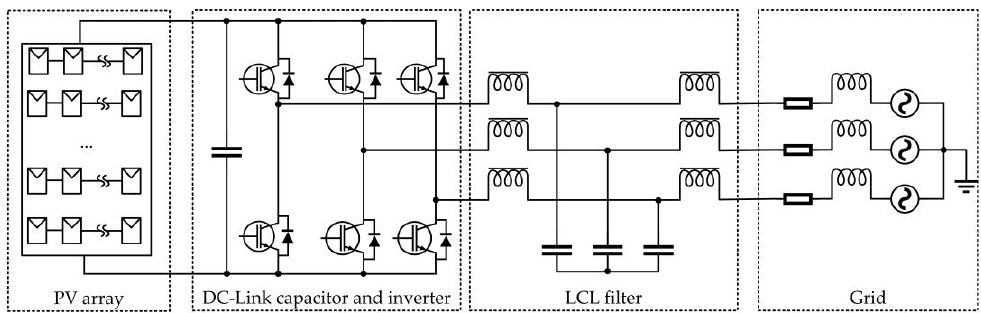
Figure 2. Principle drawing of a grid-connected three-phase inverter system.